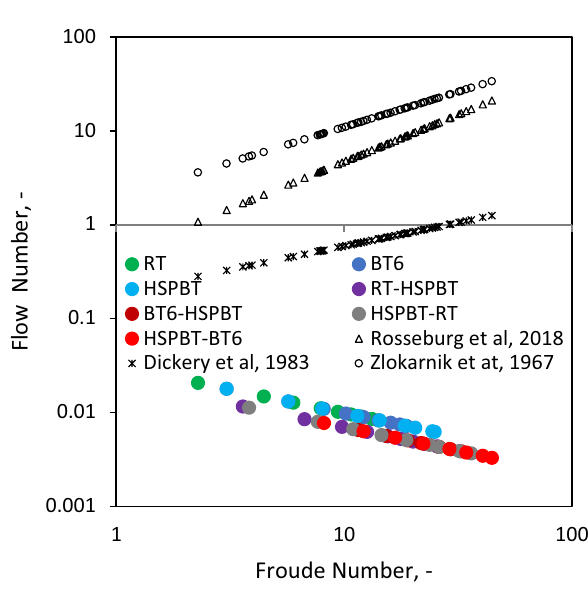
Fig. 3 Operating regime for the different impeller